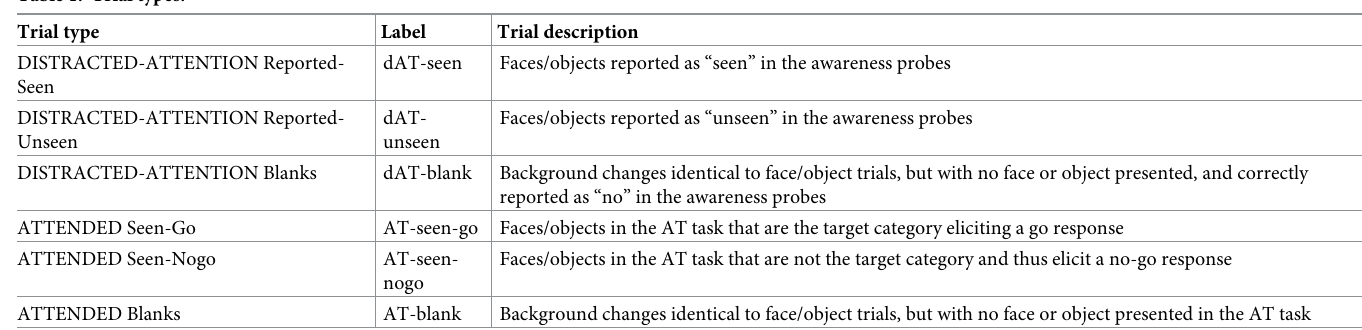
Table 1. Trial types. Trial type